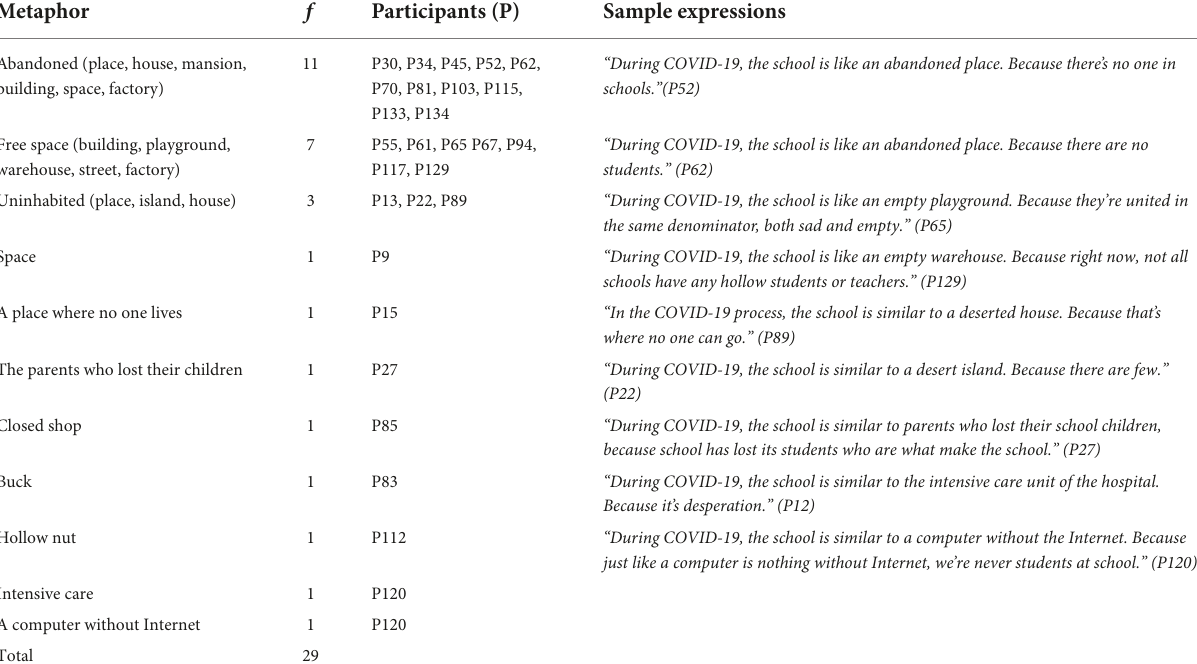
Lack of complementary elements